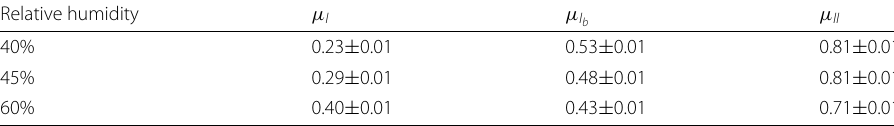
Table 2 μ coefficients for phases I, I b and II of the growth curves Relative